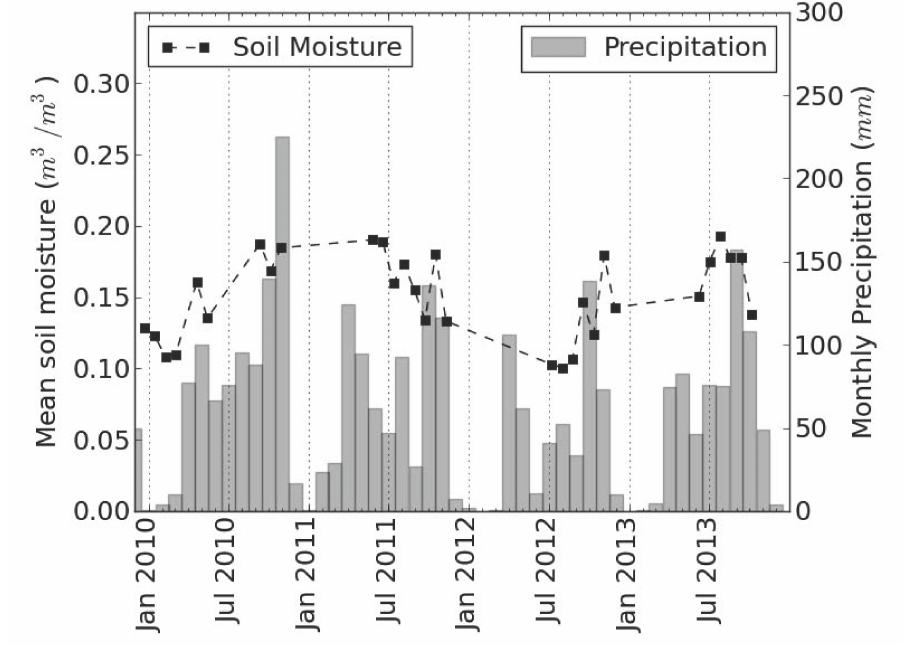
Figure 8. Temporal behaviour of mean (over space) soil moisture retrieved from